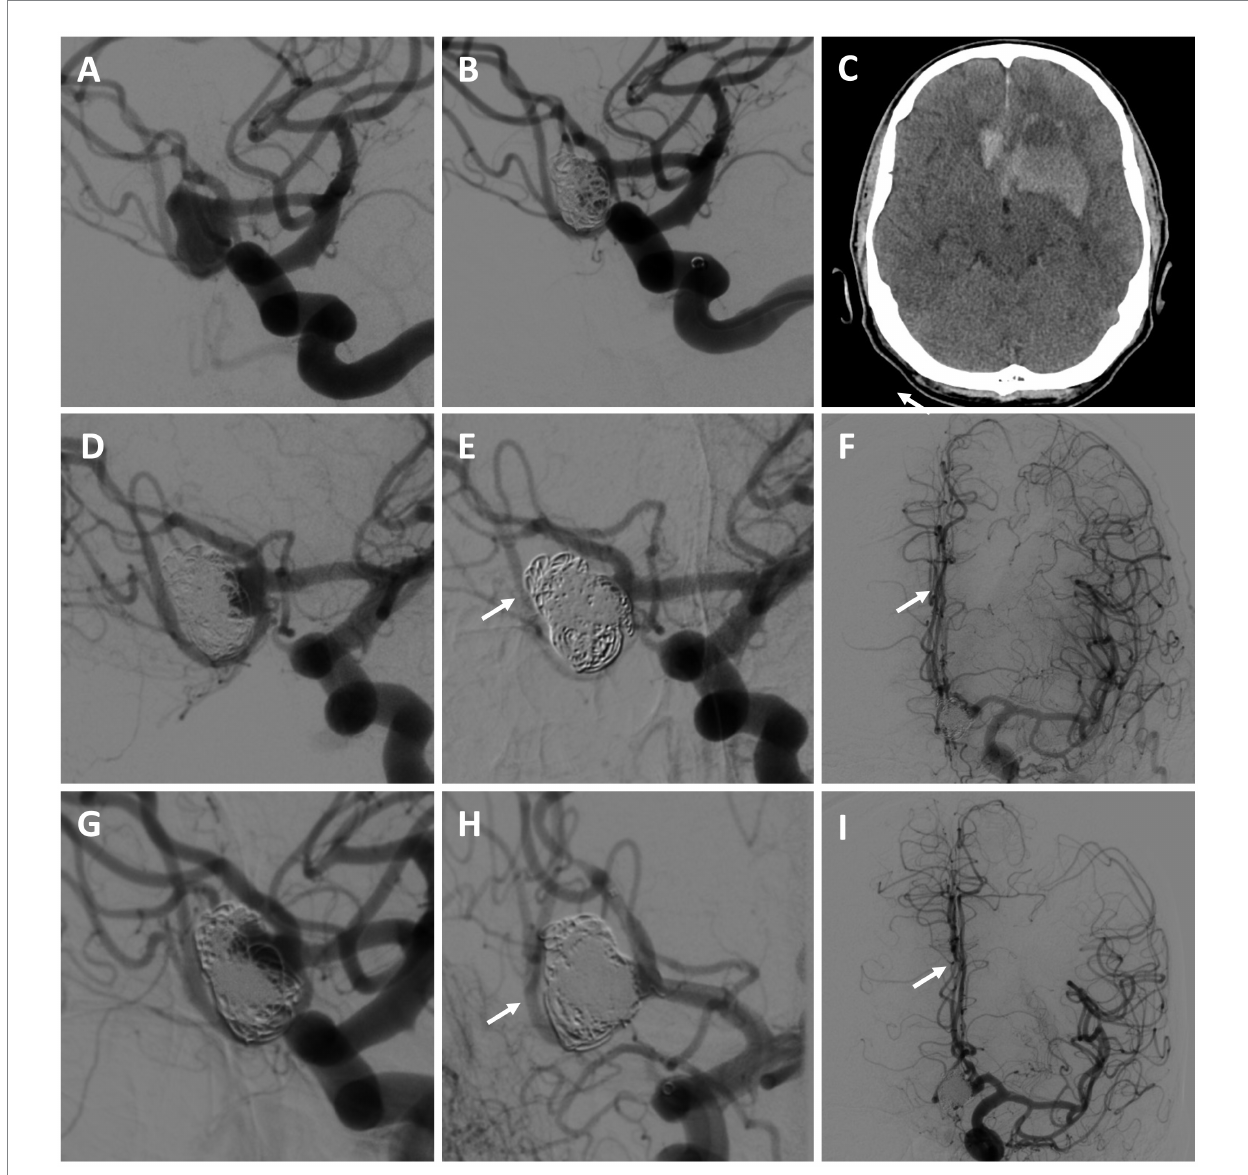
FIGURE 3 Patient #8. A 61-year-old male presented with SAH and intraparenchymal hemorrhage from a previously embolized Acomm aneurysm arising from an unpaired left A1 [ (A) left ICA angiogram demonstrating initial Acomm aneurysm, and after coil embolization (B) ; (C) head CT demonstrating SAH